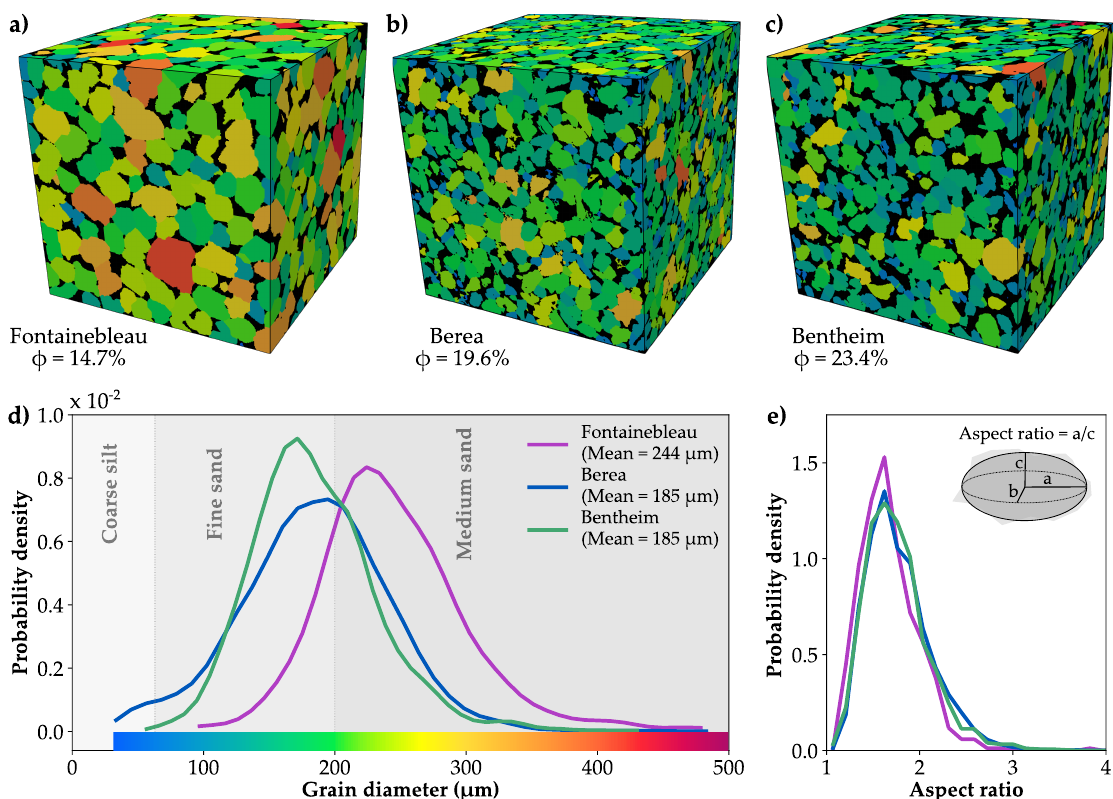
Figure 2. Micro-CT scans of the ( a ) Fontainebleau, ( b ) Berea, and ( c ) Bentheim sandstones. The individual grains are coloured by their volume-equivalent diameter. ( d ) Grain size distributions of the three sandstones exhibit different mean values and variances, and thus sorting. ( e ) Grain shape is described by the aspect ratio, which relates the major axis of an inertia ellipsoid to its minor